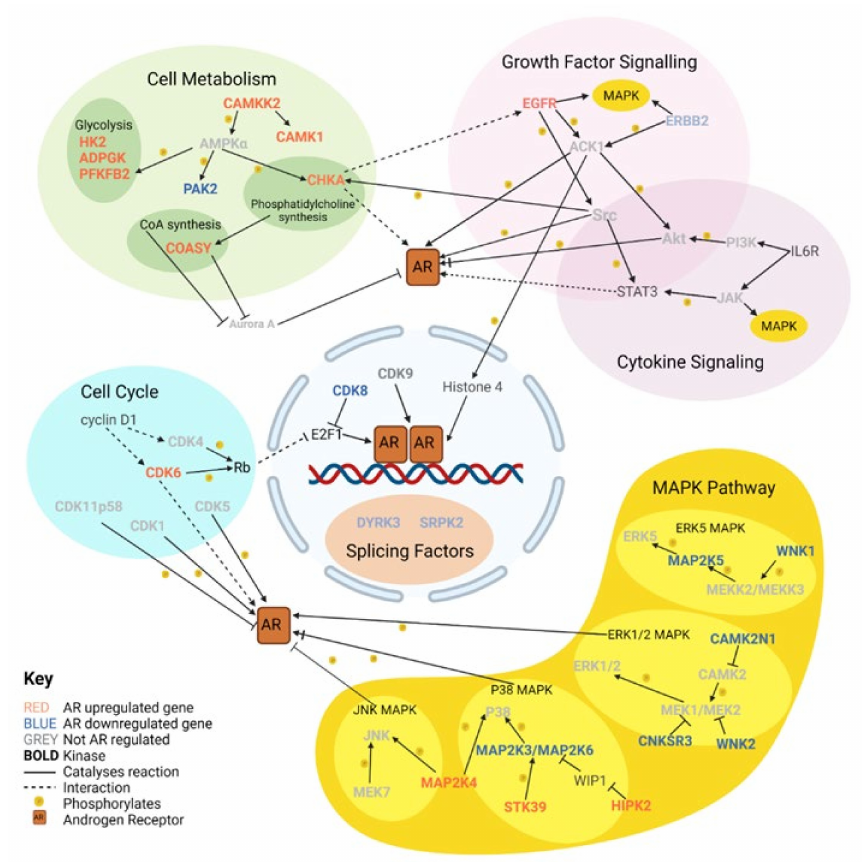
Figure 2. Key cellular pathways involving upstream and downstream kinases of the androgen receptor. Different functional groups are contained within different coloured ovoids. Within Cell Metabolism and the MAPK Pathway are subgroups represented by further coloured ovals. There are 24 AR-regulated kinases that are discussed in the main text, with other key kinases and molecules these kinases interact with